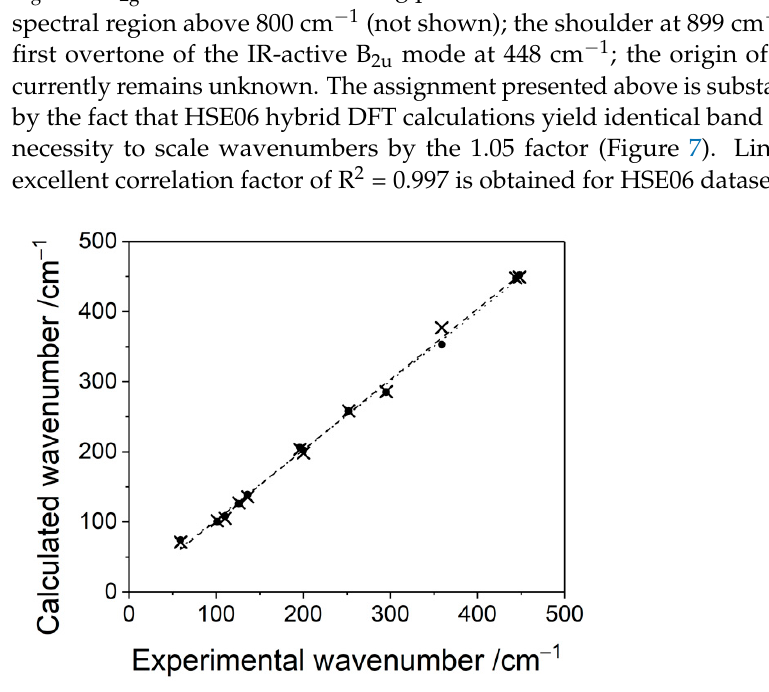
Figure 7. Correlations between theoretical and experimental wavenumbers jointly for IR and Ra- man spectra (black dotted line—linear regression with R 2 = 0.999 for corrected DFT+U dataset, black dashed line—linear regression with R 2 = 0.997 for HSE06 dataset; both not bound to pass at (0,0)).